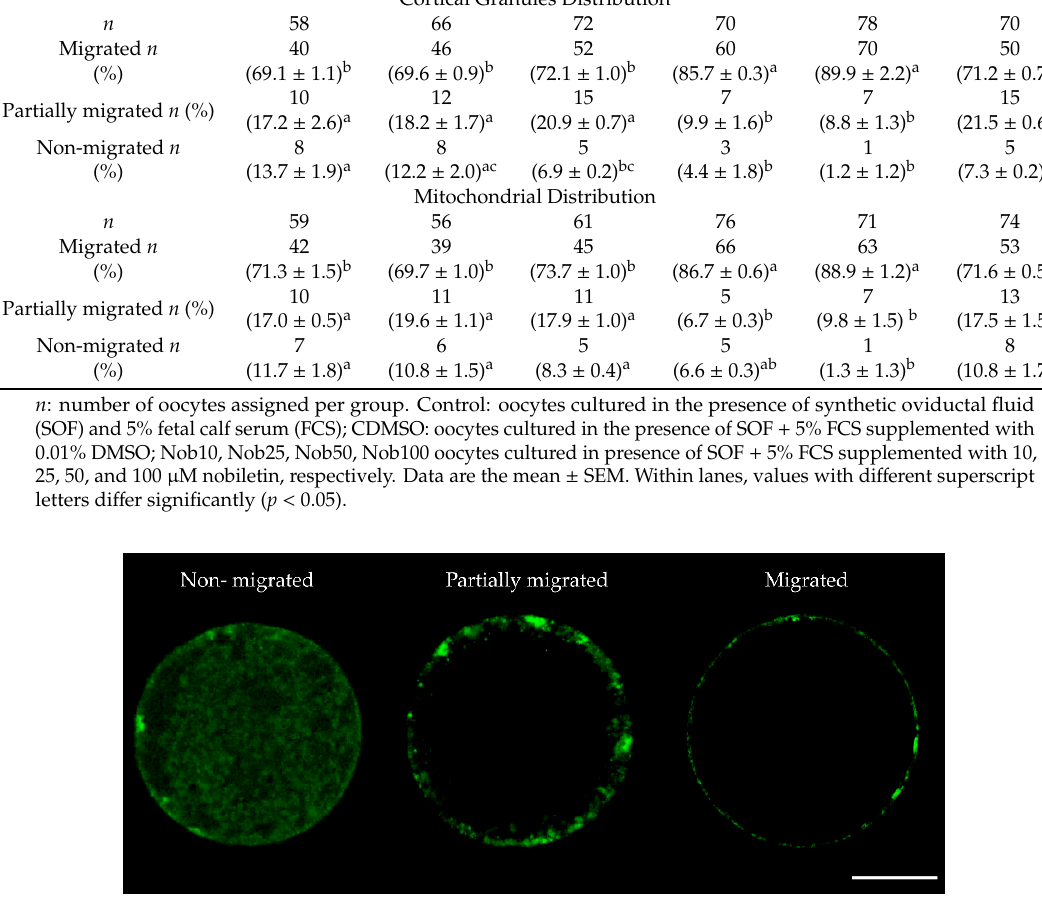
Figure 1. Representative fluorescent images of cortical granules (CG) distribution patterns in bovine oocytes after in vitro maturation in the presence of nobiletin. Scale bar 50 μ m.